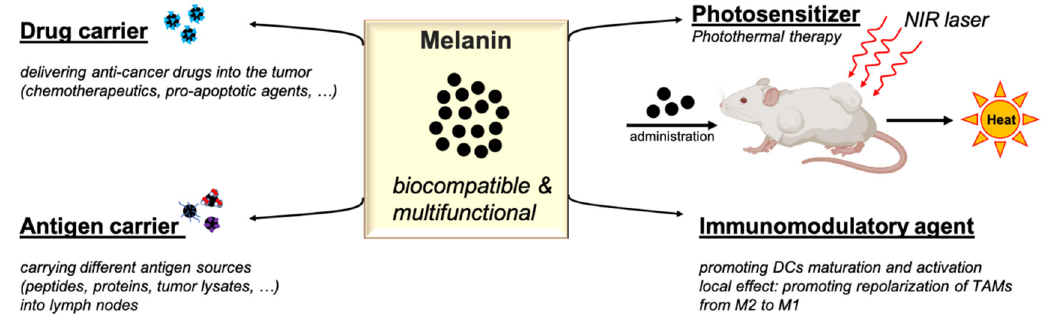
Figure 1. Schematic illustration of the applications of melanin-based platforms in cancer therapy. NIR: Near-infrared; TAM: tumor-associated macrophage.